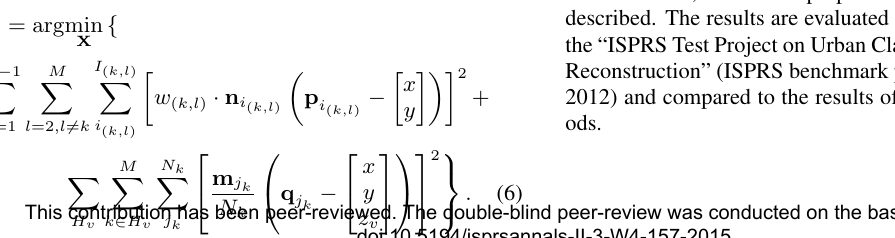
(c) A side view of combined grid data, i.e. local boundary lines LBL and local surface planes LSP . Figure 4. Local boundary lines and local surface planes in a grid. The weighted and scaled QEF is defined as